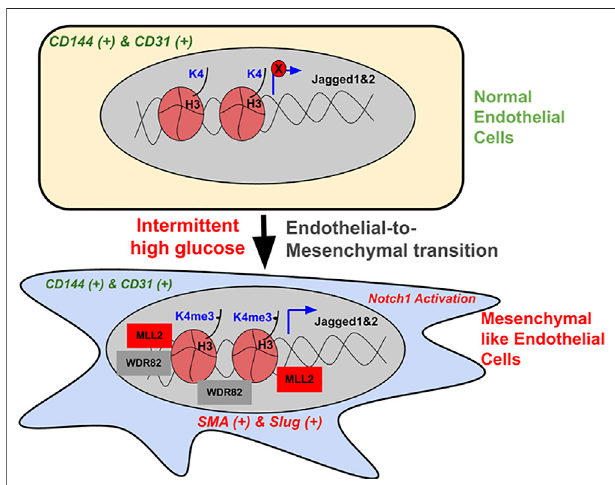
FIGURE 7 | Schematic illustration of the intermittent high-glucose- dependent induction of H3K4me3 promoting Notch signaling-dependent acquisition of mesenchymal character of endothelial cells. In normal endothelial cells, H3K4me3 levels remain to be minimal and the expression of Notch-associated ligands Jagged1 and Jagged2, including the activation of Notch pathway is very limited, thereby maintaining endothelial phenotype. Upon intermittent high-glucose challenge, endothelial cells exhibit a heightened level of H3K4me3 contributed by an increase in SET1/ COMPASS proteins MLL2 and WDR82. Elevated H3K4me3 consequently enriches on the promoter region of Notch ligands Jagged1 and Jagged2, thereby causing their expression, which in turn causes Notch activation. Such hyperactivation of Notch signaling supports the acquisition of mesenchymal character in endothelial cells. Interplaying with MLL through small molecule inhibitors or by siRNA-dependent knockdown caused reversal of intermittent high-glucose dependent Notch activation and concurrent inhibition of acquiring mesenchymal character by endothelial cells.